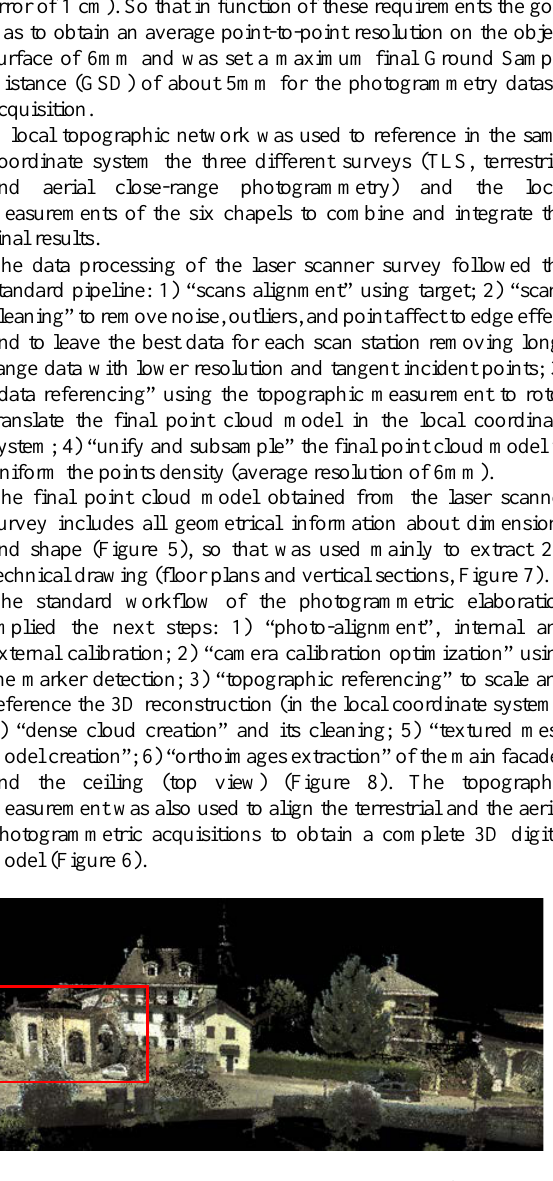
Figure 4: Leica Pegasus Backpack point cloud of Chapel two (landscape scale).